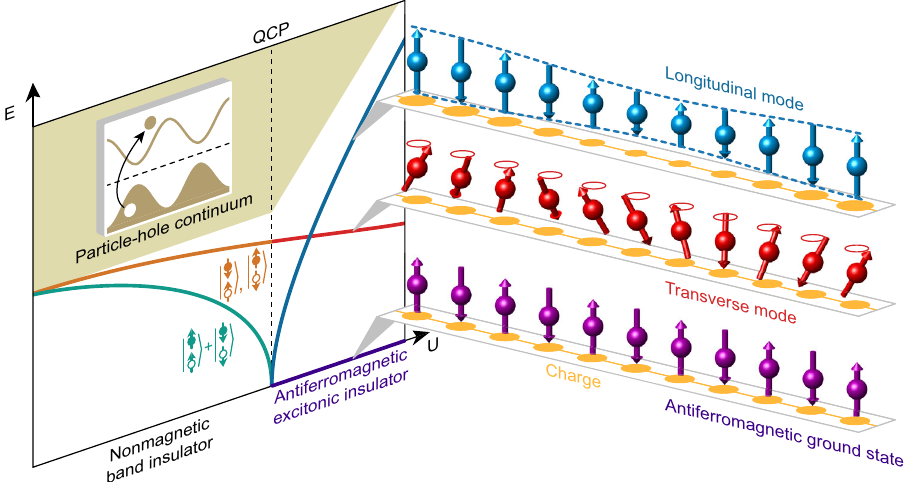
Fig. 1 Antiferromagnetic excitonic insulator phase diagram. Charge excitations in paramagnetic band insulators consist of either electron-hole excitations across the insulating band gap (brown shaded area) or of bound electron-hole excitons below the particle-hole continuum [electrons (holes) are indicated with fi lled (empty) circles]. An antiferromagnetic excitonic insulator is established through the condensation of the predominately spin-triplet character exciton mode with spin quantum number S z = 0. The excition is a superposition of an up-spin electron in the conduction band paired with an up-spin hole (equivalent to a down-spin electron) and a down-spin electron paired with a down-spin hole 4 . The other spin-triplet excitions S z = ±1 feature an up-spin electron and a down-spin hole or a down-spin electron and an up-spin hole. Upon increasing Coulomb interaction U the S z = 0 exciton condenses into the ground state at a QCP 4 , establishing magnetic order and leaving an excitonic longitudinal mode as the key signature of this